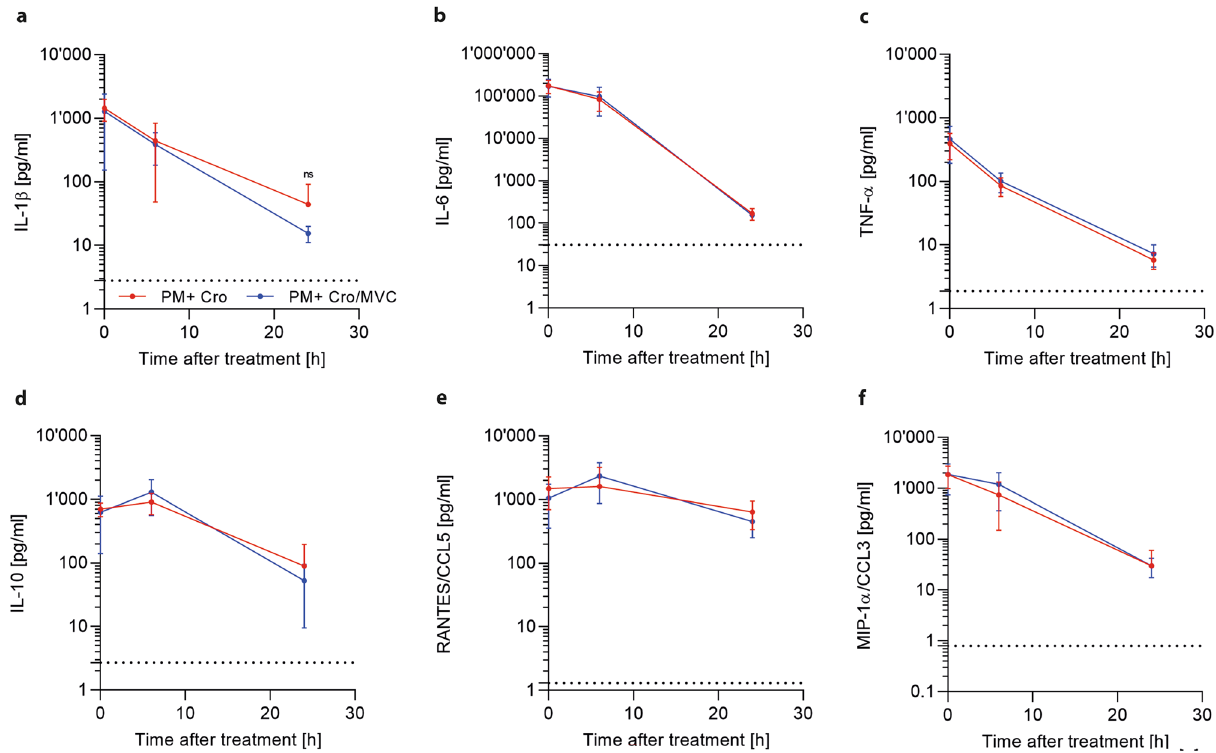
Figure 6. Inflammatory cytokines and chemokines during acute PM. ( a-f) MVC treatment did not affect cytokine and chemokine levels at any given timepoints (PM + Cro n = 7–12; PM + Cro/MVC n = 7–13, depending on timepoints). Data are presented as mean ± SD. * p < 0.05, ** p < 0.01, *** p < 0.001, and **** p < 0.0001 (Mann– Whitney